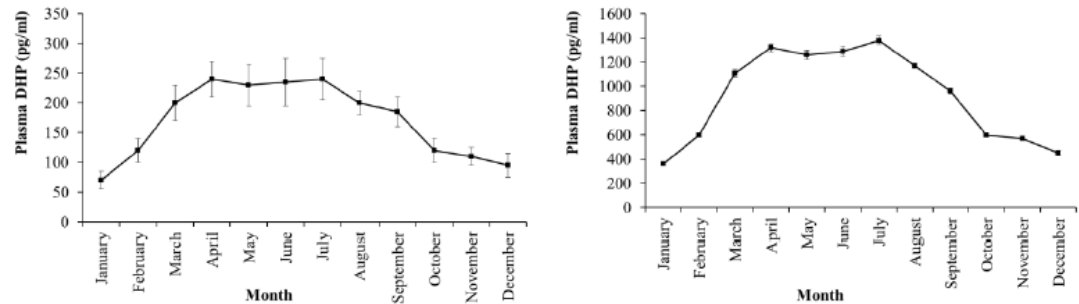
Figure 8. Monthly change in 17 α , 20 β -dihydroxy-4-pregnen-3-one (DHP) levels in plasma ( left ) and ovaries ( right ) of the wild-caught blue tang fish (n the same as Figure 2a).